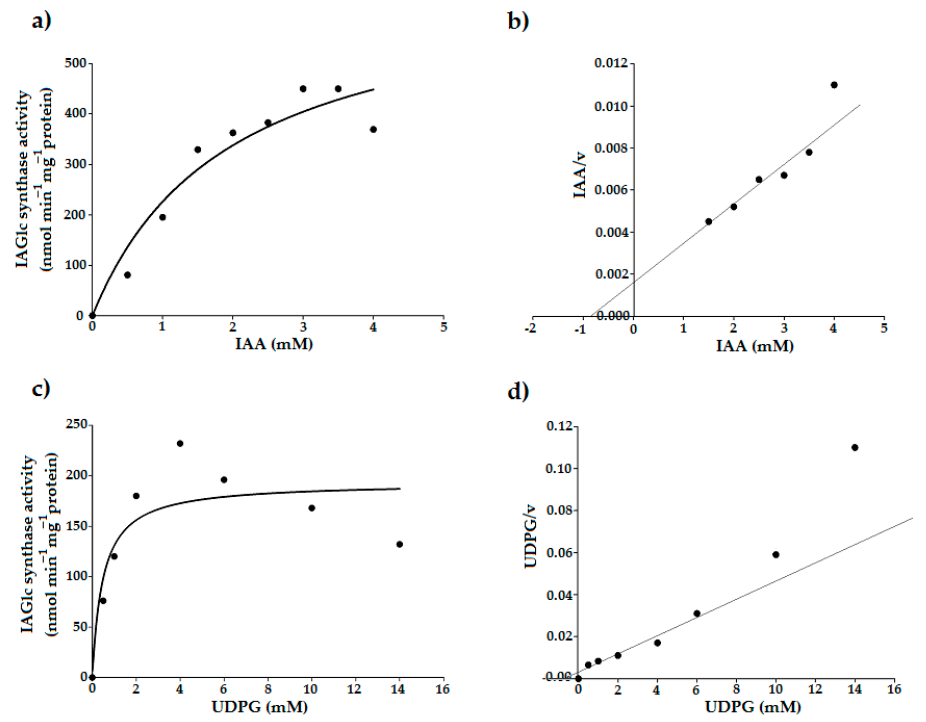
Figure 3. Determination of kinetic parameters of IAGlc synthase. Effect of IAA concentration on the IAGlc synthase activity: Michaelis–Menten plot ( a ) and Hanes–Woolf plot ( b ). Effect of UDPG concentration on the IAGlc synthase activity: Michaelis–Menten plot ( c ) and Hanes–Woolf plot ( d ). The K M and V max values were calculated using Hanes–Woolf plots (IAA/v = f (IAA) and UDPG/v = f (UDPG) , respectively). Table 2. Kinetic parameters of recombinant maize IAGlc synthase.